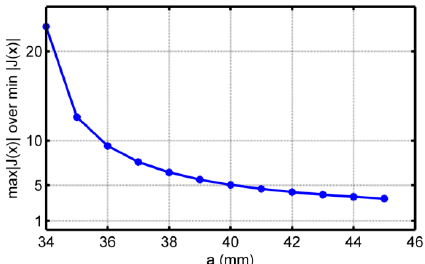
Figure 4. Calculation results: (cid:2015) vs. parameter “ a ” for fixed air gap.